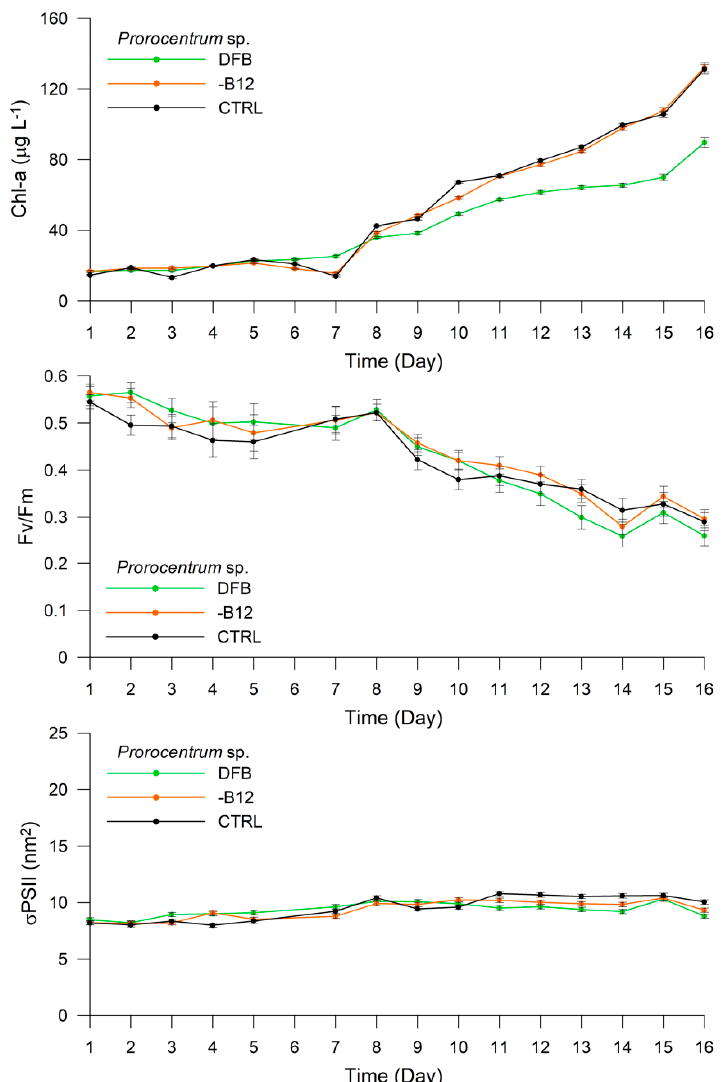
Figure 3. Experiment 1. Changes in chlorophyll-a (Chl-a) concentration ( µ g L − 1 ), maximum PSII photochemical efficiency (Fv/Fm), and maximum PSII effective absorption cross-section ( σ PSII) (nm 2 ) in Prorocentrum sp. under different treatments.